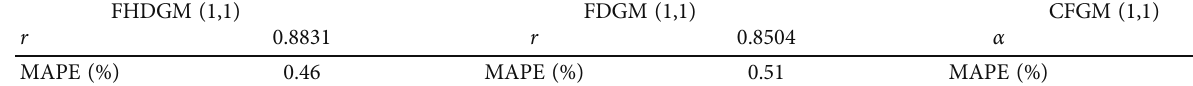
Table 13: Optimal parameters of the three models in world renewable energy consumption.